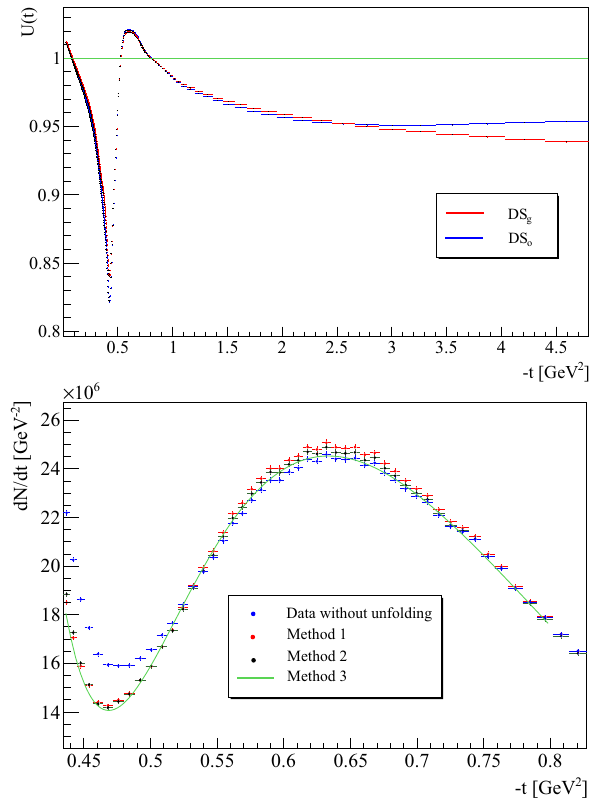
Fig. 6 The unfolding correction histograms U ( t ) for data set DS g and DS o , which correspond to the resolution values summarized in Table 2 (left panel). Comparison of the unfolding of d N el / d t using the three unfolding methods around the diffractive minimum (right